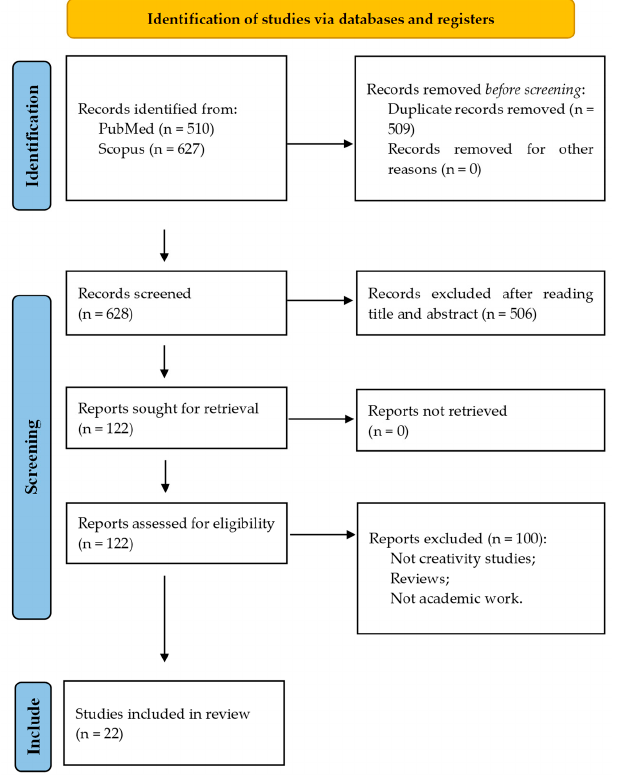
Figure 1. PRISMA fl ow diagram charting study selection for the scoping review. Figure 1. PRISMA flow diagram charting study selection for the scoping